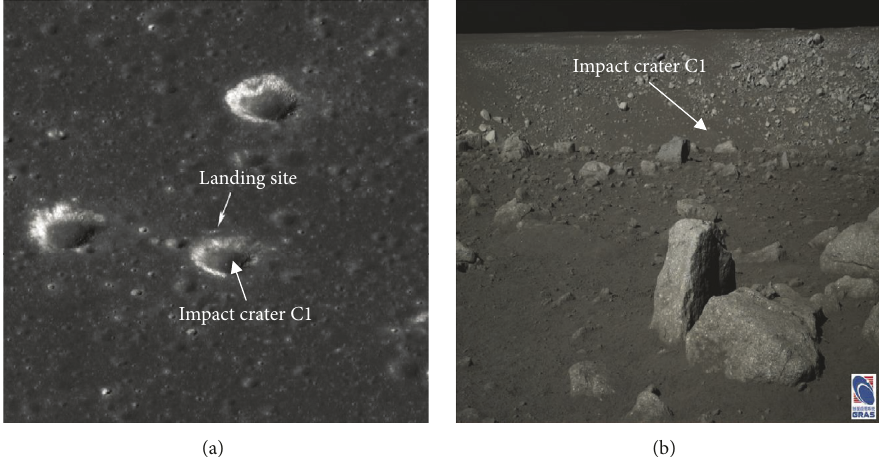
Figure 7: Chang’E 3 landing site and the topography of the impact crater C1. (a) is from Arizona State University, and (b) is from the Science and Application Center for Moon and Deep Space